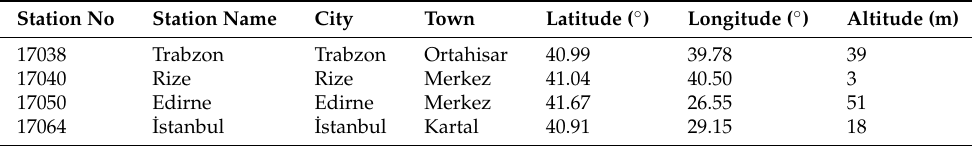
Table 1. Meteorological station samples from station database